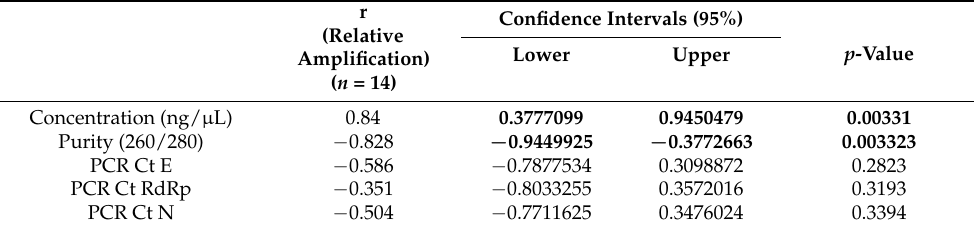
Statistically significant values are shown in